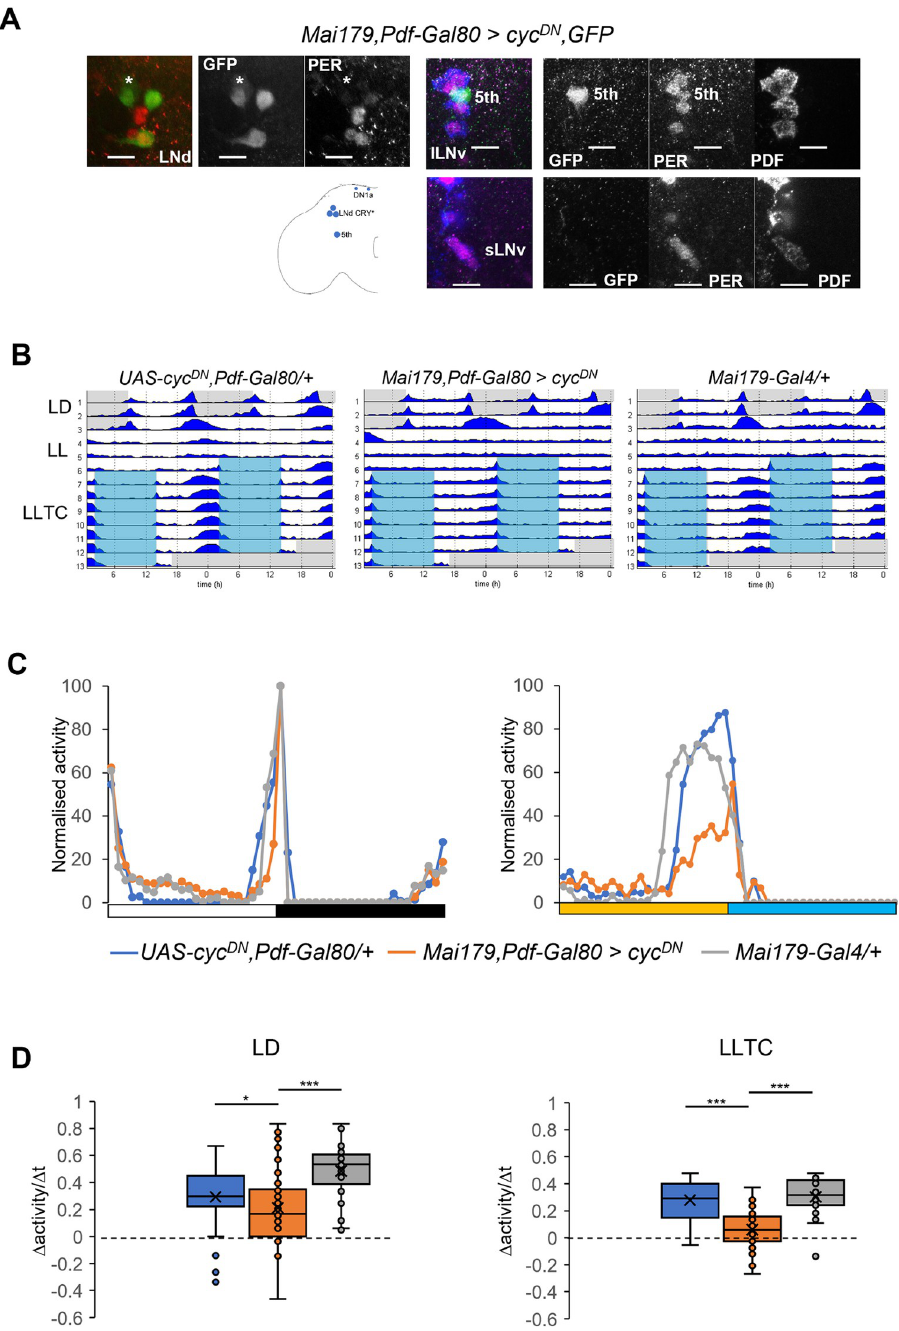
Fig 3. Circadian clock disruption in EO neurons prevents synchronized behavior in temperature cycles during constant light. A) Immunostaining of a Mai179 , Pdf-Gal80 > cyc DN , GFP brain at ZT2 in LD (25˚C). GFP: green; PER: red; PDF: blue. Left panel: LNd. The � marks a non-LNd GFP + cell. Scale bar: 10 μ m. Cartoon depicts clock neurons expressing cyc DN in Mai179 , Pdf-Gal80 flies. B) Average actograms of one representative experiment. N: UAS-cyc DN , Pdf-Gal80/+ = 14, Mai179 , Pdf-Gal80 > cyc DN = 31, Mai179 - Gal4/+ = 16. C) Median of the normalized locomotor activity during the last day of LD (left) and the 6 th day of LLTC (right). N: UAS-cyc DN , Pdf-Gal80/+ = 34, Mai179 , Pdf- Gal80 > cyc DN = 48, Mai179 - Gal4 /+ = 32. D) Box plots showing the slope of the evening peak on the last day of LD (left) and the 6 th day of LLTC (right). Same flies as in (C). For all the genotypes in LD ZT min = 9.5. In LLTC, UAS- cyc DN , Pdf- Gal80/+ and Mai179 , Pdf-Gal80 > cyc DN : ZT min 7.5 and Mai179 - Gal4 /+: ZT min 6. UAS-cyc DN , Pdf-Gal80 /+: ZT max 11.5, Mai179 , Pdf-Gal80 > cyc DN : ZT max 10.5, and Mai179 - GAL4 /+: ZT max 9.5.